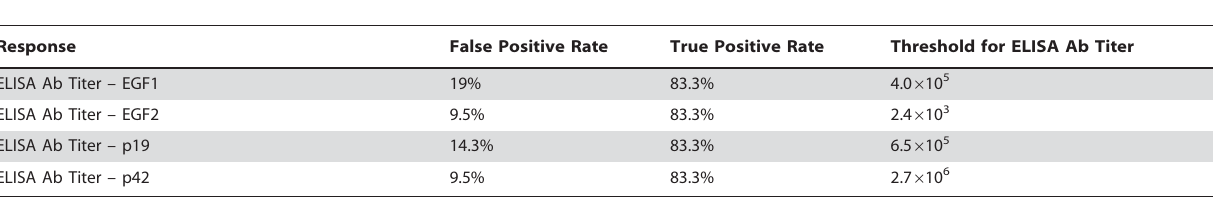
Table 7. Results from ROC graphs for Predicting Self-Cure by Using ELISA with FVO strain Ag expressed in E. coli